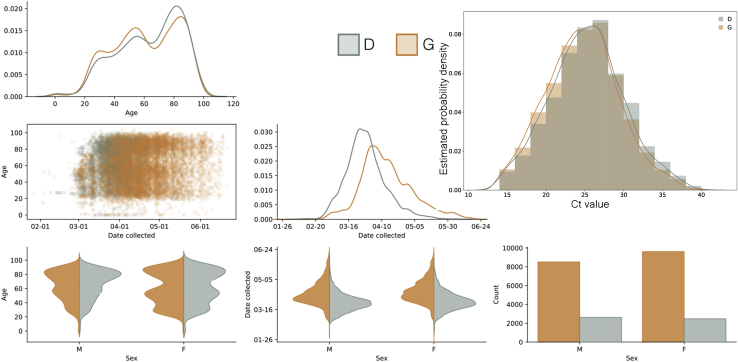
Probability of Observing Spike 614G Virus in Patients Grouped by Age and Sex, Related to Figure 4Panels on the lower diagonal show collected pairwise plots based on a UK-wide (England, Wales, Scotland, and Northern Ireland) multivariate dataset for the sample collection date, and the age and sex of the patient. Kernel Density Estimation (KDE) and count plots are on the diagonal. The upper right panel shows the estimated frequency of PCR cycle threshold (Ct) for D/G variants overlaid with kernel density estimates. Samples where the amino acid at position 614 was not recorded and samples with a Ct value of less than 14 or greater than 40 were excluded.